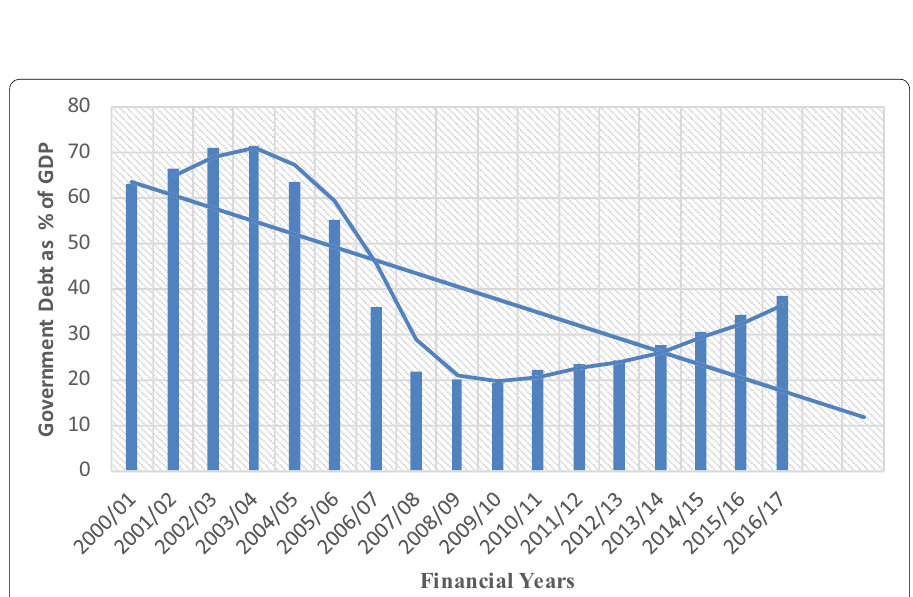
Fig. 3 The Trend of Uganda’s Public debt as a % of GDP for Financial Years 2000/01-2016/17 (Bank of Uganda (2017) and World Bank